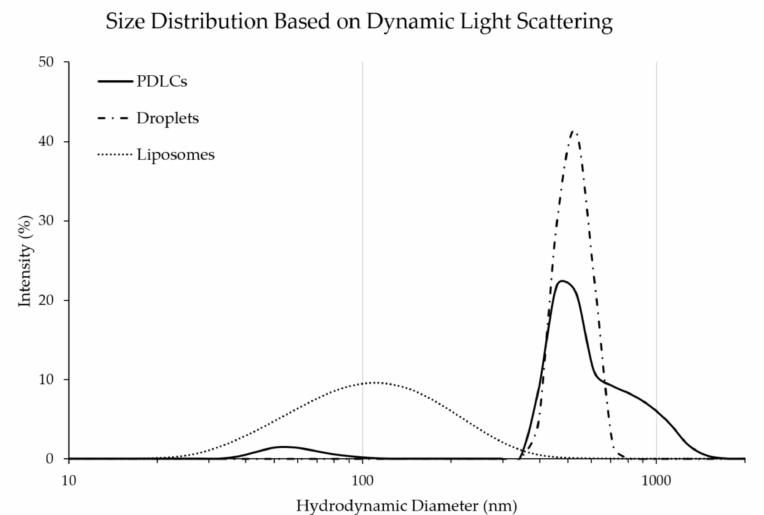
Figure 4. The size distribution of droplets, liposomes, and PDLCs. The clustering of droplets and liposomes increases the overall median diameter of the particles. Distributions are averaged from three sample